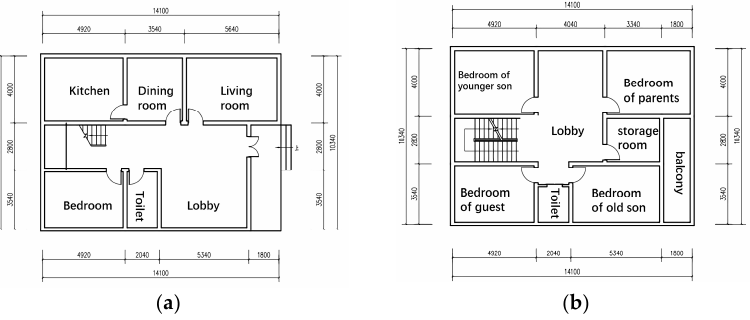
Figure 10. ( a ) Plan of first floor; ( b ) plan of second floor.